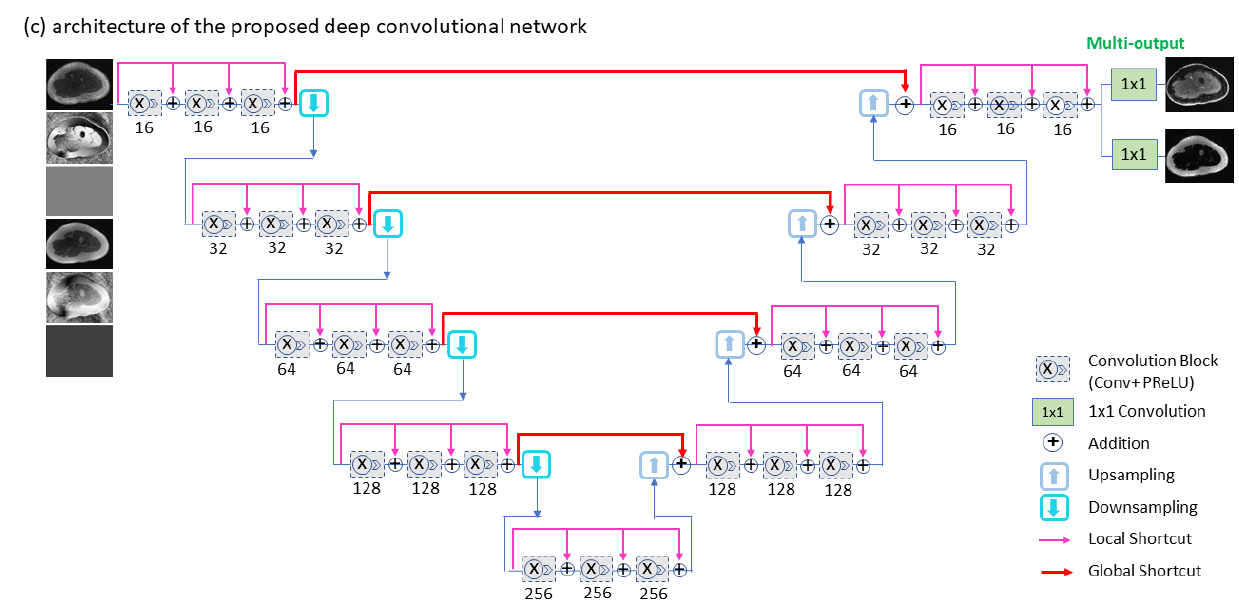
Figure 1. Deep learning-based water–fat separation from dual-echo images. ( a ) A deep neural network was employed to provide end-to-end mapping from dual-echo images and related echo times to the corresponding water/fat images. ( b ) Clinical pipeline for generating reference water/fat images from dual-echo images using the projected power method. Here, phasor calculation and phasor selection were the only components used for water–fat separation, while coil compression and downsampling/upsampling were used to reduce data processing time. ( c ) A multi-output deep convolutional neural network for water–fat separation had a hierarchical network architecture and unique shortcut connections.